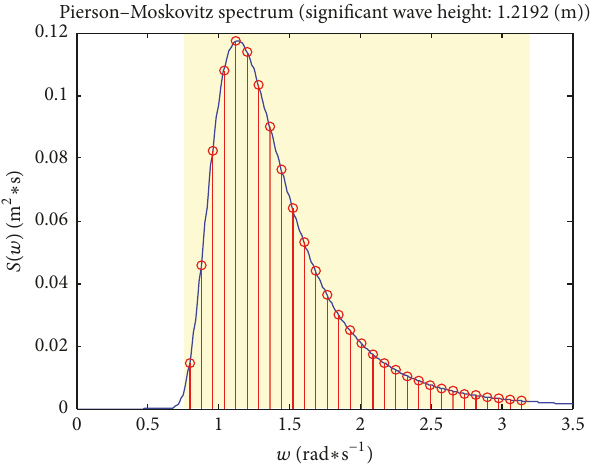
Figure 3: Wave spectrum curve for Sea State 3.